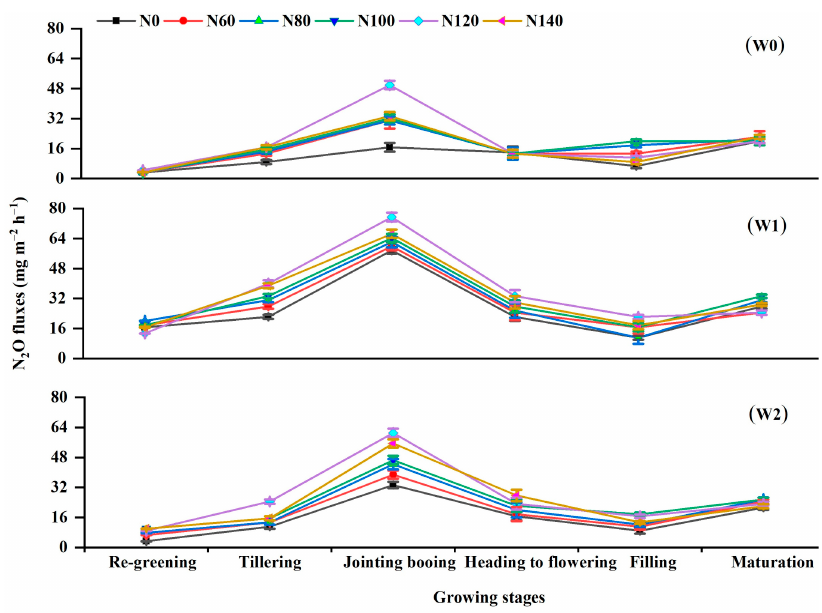
Figure 4. Variations in N 2 O fluxes, as affected by irrigation regimes with different N application rates during the rice-growing period. W0, W1, and W2 represent continuous flooding, intermittent irrigation, and control irrigation (W2), respectively. Urea application at rates of 0 (N0), 60 (N60), 80 (N80), 100 (N100), 120 (N120), and 140 (N140) kg N ha − 1 .